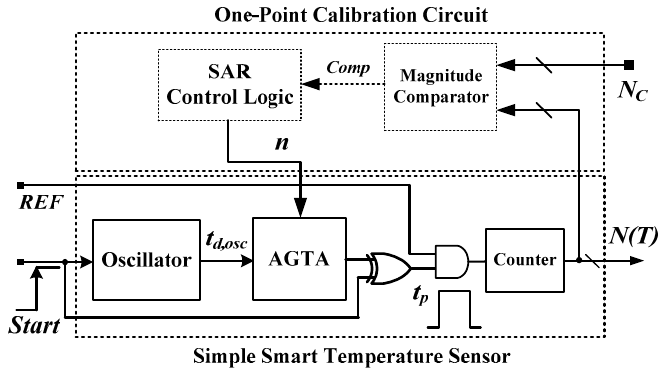
Figure 3. Architecture of smart temperature sensor with one-point calibration support.